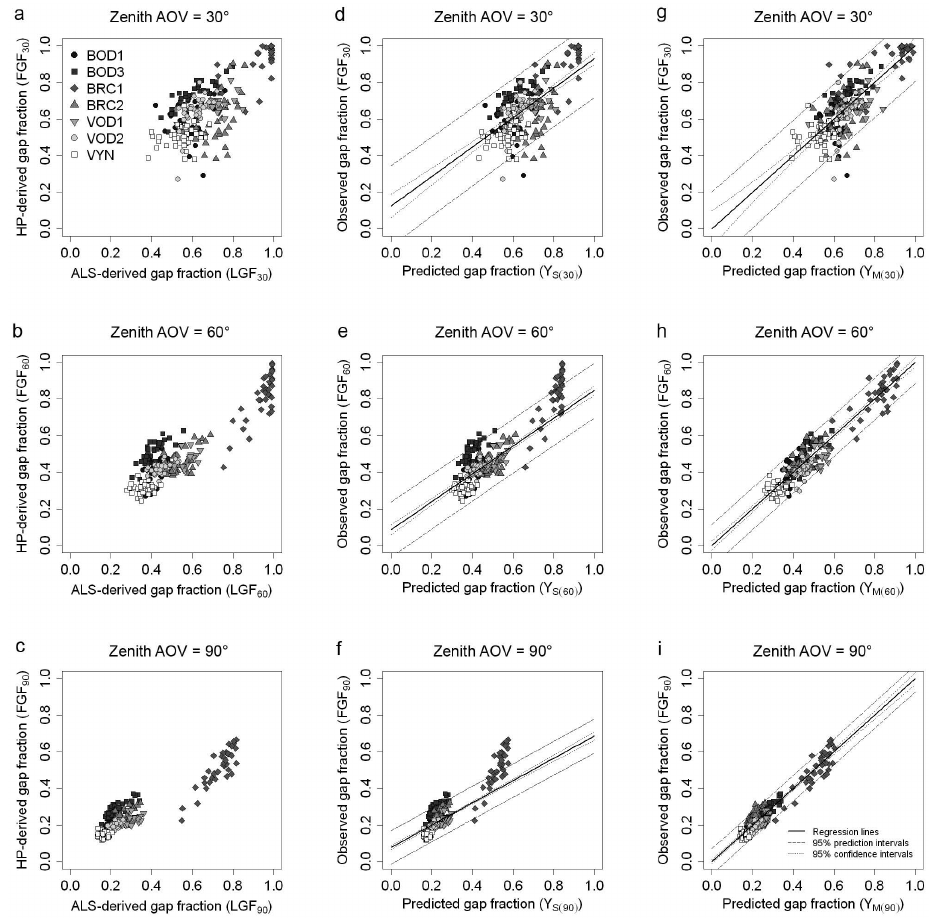
Fig. 5. Relationship between ALS-derived (LGF θ ) and HP-derived gap fraction (FGF θ ) ( a , b , c ) and between predicted and observed values of gap fraction obtained from simple ( d , e , f ) and multiple ( g , h , i ) linear regression models across three representative zenith angle AOV (30 ◦ , top; 60 ◦ , centre; and 90 ◦ , bottom); legends in sub-figures (a) and (i) apply to